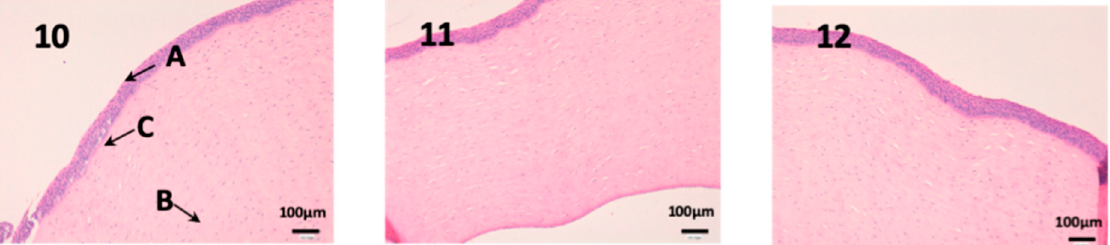
Figure 11. Photo 10: Histological image of untreated cornea observed at 400×; Photo 11: Histological image of cornea treated with CP-Solution observed at 400×; Photo 12: Histological image of cornea treated with CP-NPs observed at 400×. (A) Stratified flat keratinized epithelium; (B) own laminate. (C) Bowman’s membrane.